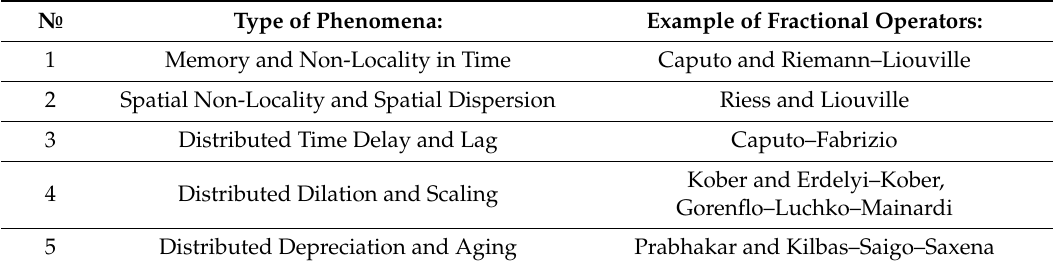
Table 1. Examples of the correspondence between the some fractional derivatives (or integrals) and the type of